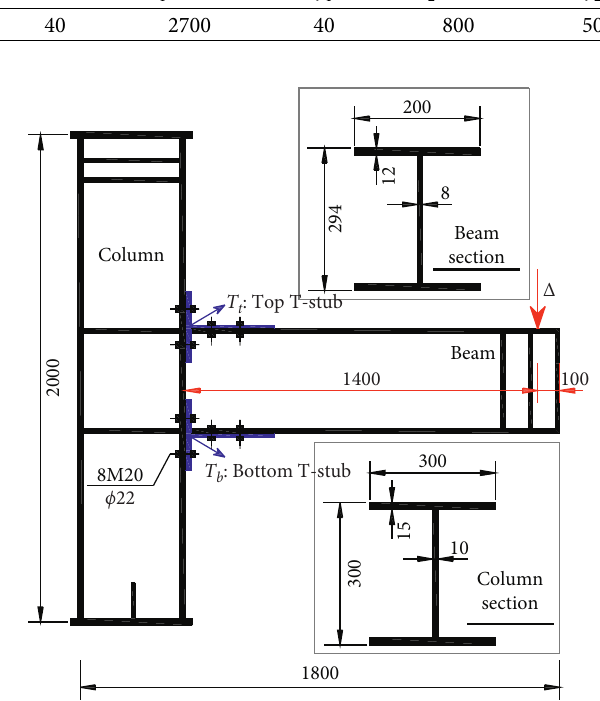
Figure 5: Geometry, dimensions, and loading point of the T-stub connection (in mm).